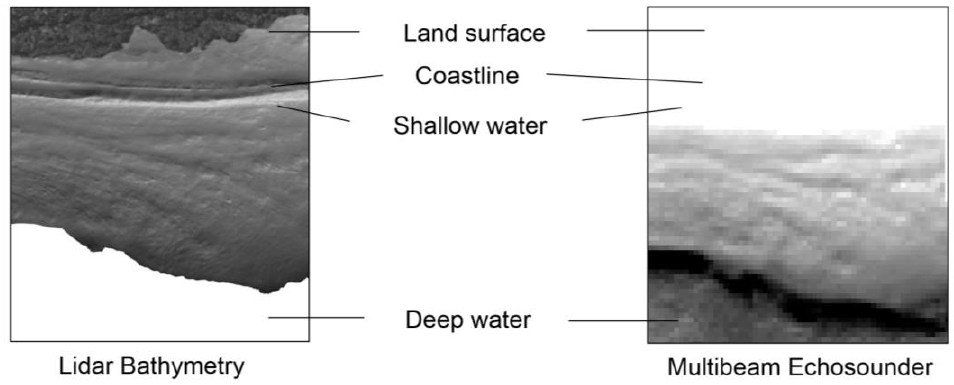
Figure 9. Comparison between bathymetric LiDAR and multibeam echosounders (Dobczyce res- ervoir, Poland).